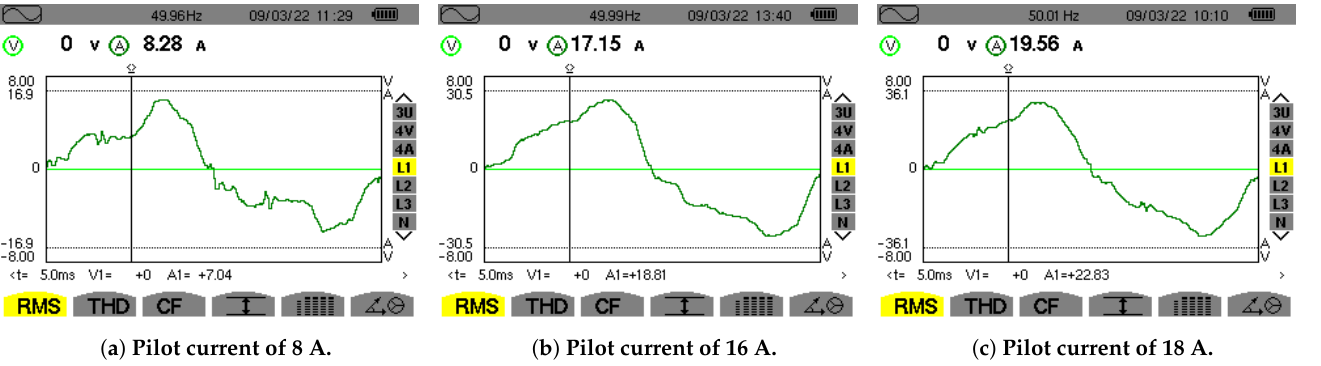
Figure 6. Screenshots of the current waveform from the grid analyzer during the charging session for different pilot current values: ( a ) 8 A, ( b ) 16 A, and ( c ) 18 A.